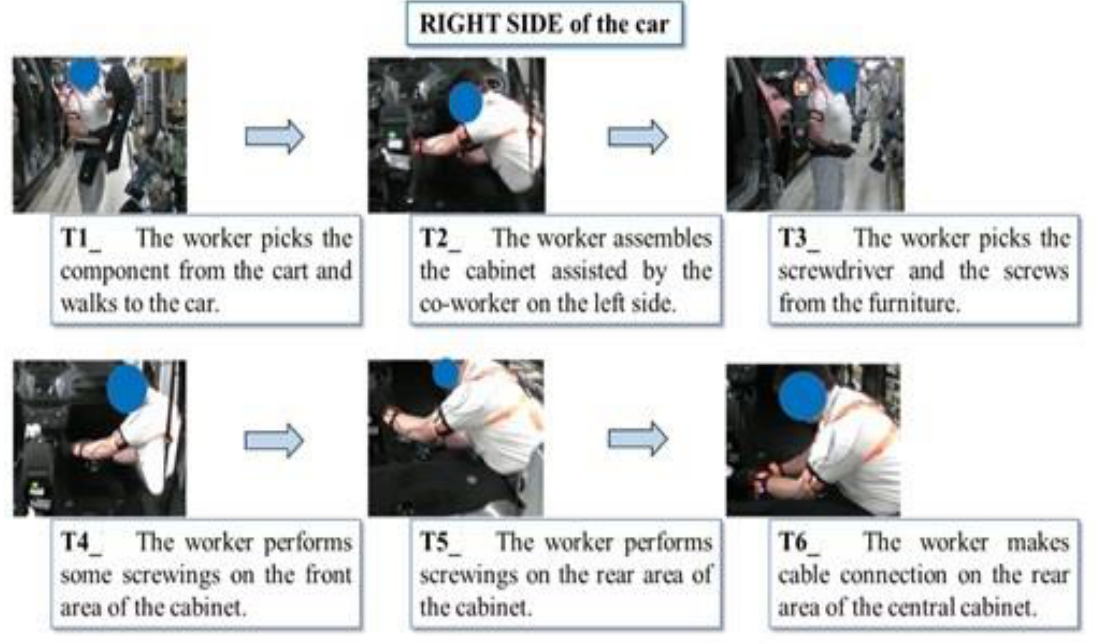
Figure 1. Working activity on the right side of the workstation.